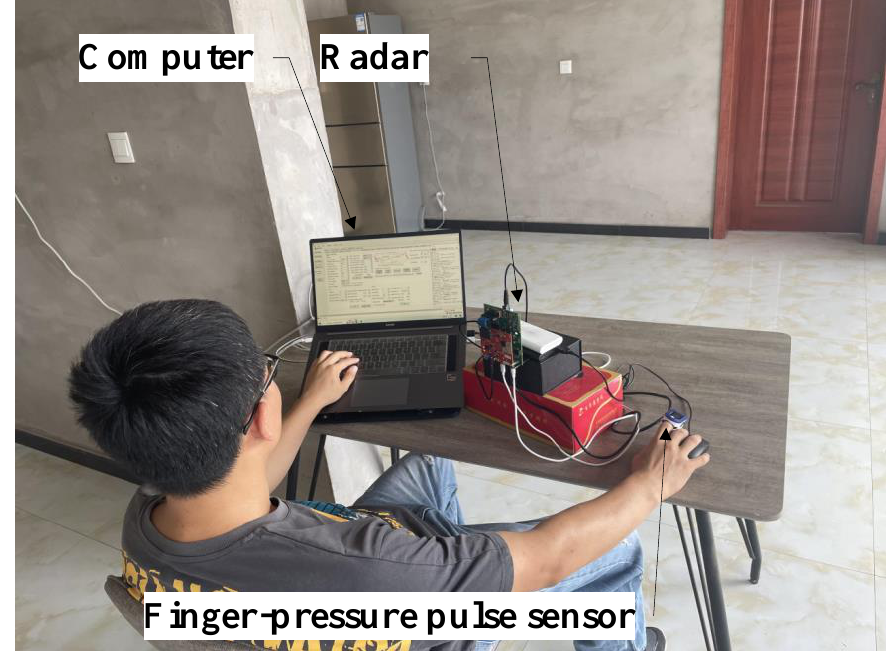
Figure 5. Experimental environment.